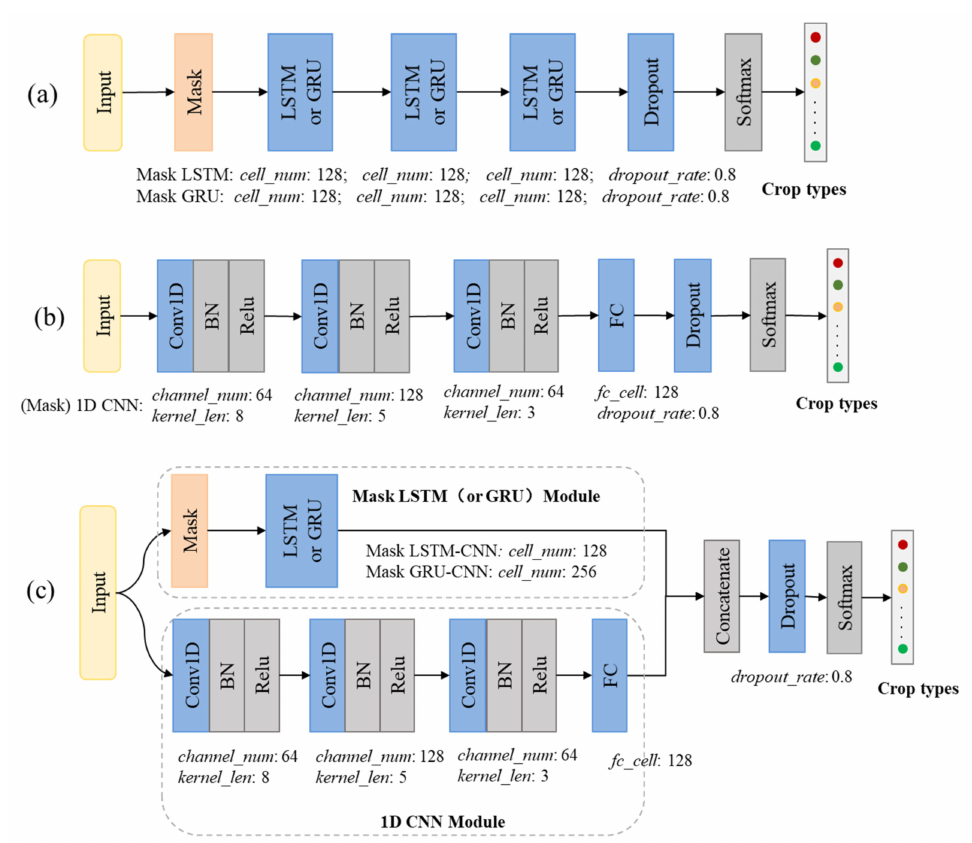
Figure 4. Networks in the first group using unfilled Sentinel-2 time series data. ( a ) Mask LSTM RNNs and Mask GRU RNNs; ( b ) (Mask) 1D CNNs; and ( c ) Mask LSTM-CNNs and Mask GRU-CNNs. channel_num, the number of channels in a convolutional layer; kernel_len, the length of kernels in a convolution layer; dropout_rate, the dropout rate; cell_num, the number of LSTM or GRU units in a layer; BN, batch normalization; FC, fully connected; Conv1D, one-dimensional